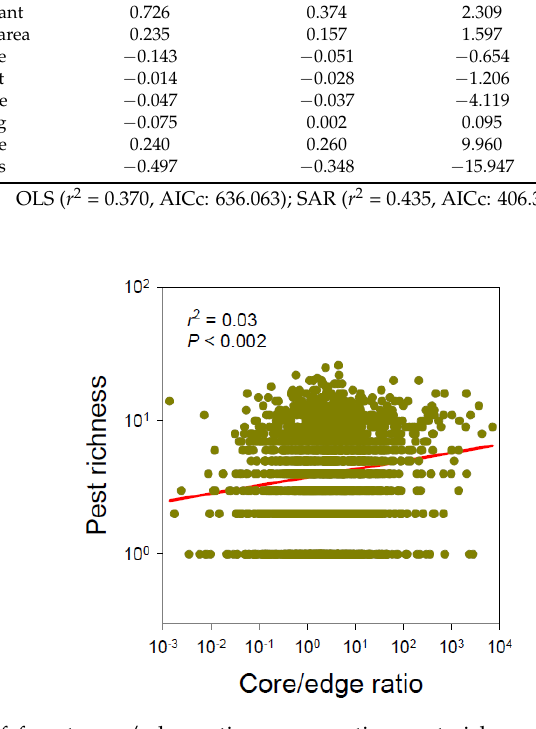
Figure 2. Effects of forest core/edge ratio on nonnative pest richness across the forests in the conterminous continental United States ( N = 2098 counties).